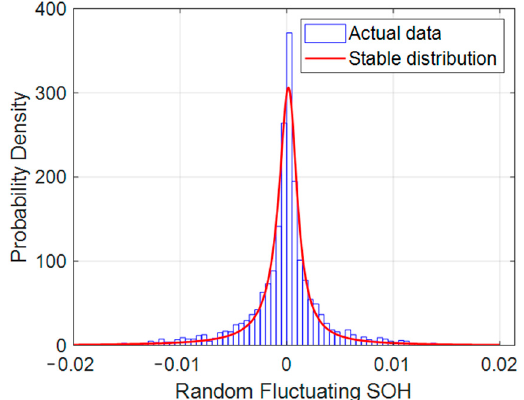
Figure 8. Comparison diagram between random fluctuation data and the Stable distribution